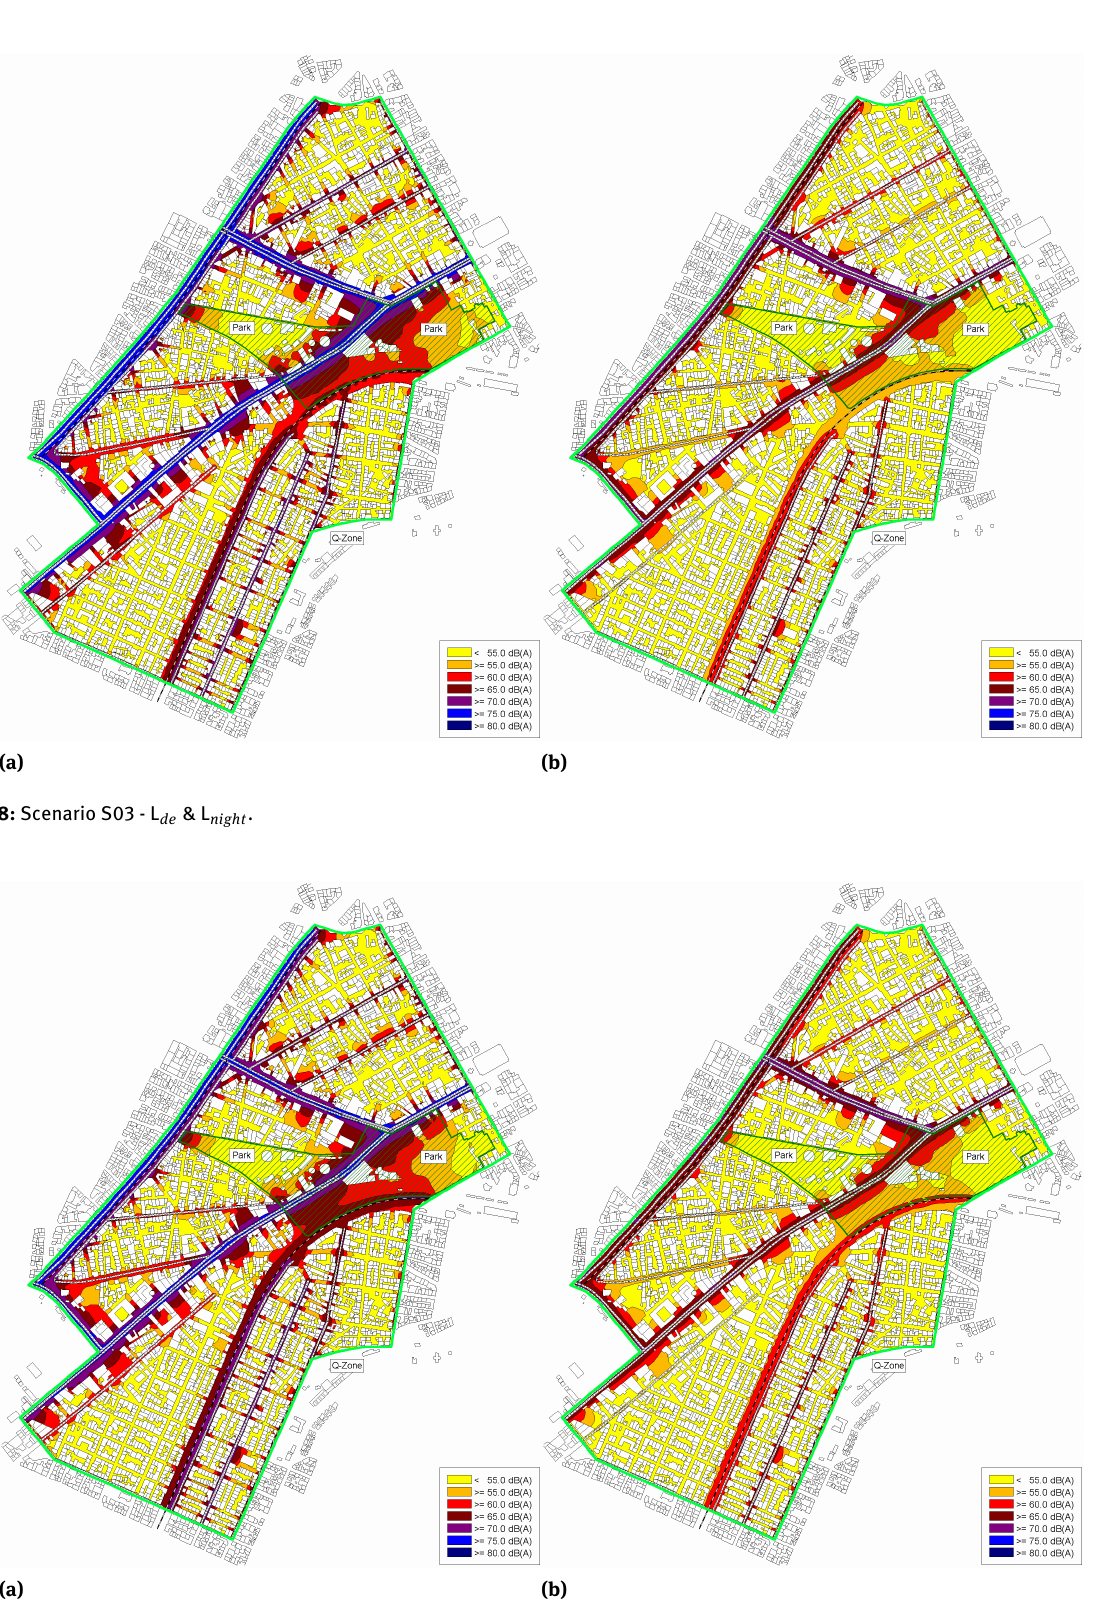
Figure 9: Scenario S04 - L